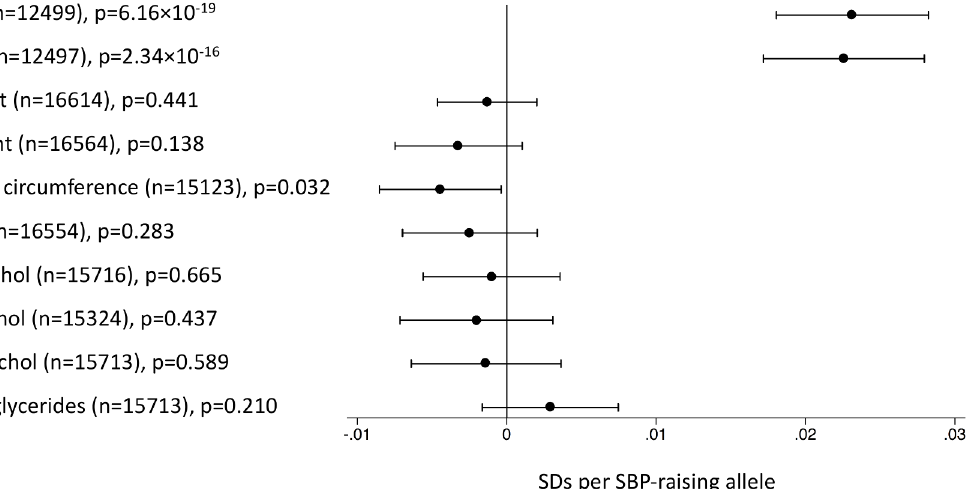
Fig 2. Associations of the systolic blood pressure genetic score with quantitative traits in the EPIC-InterAct study. This figure shows the investigation of pleiotropic associations of genetic score for SBP with quantitative traits in the EPIC-InterAct study [26]. Effect sizes are expressed in SDs per SBP-raising allele. Analyses were adjusted for age, sex, center of recruitment, and subcohort status.